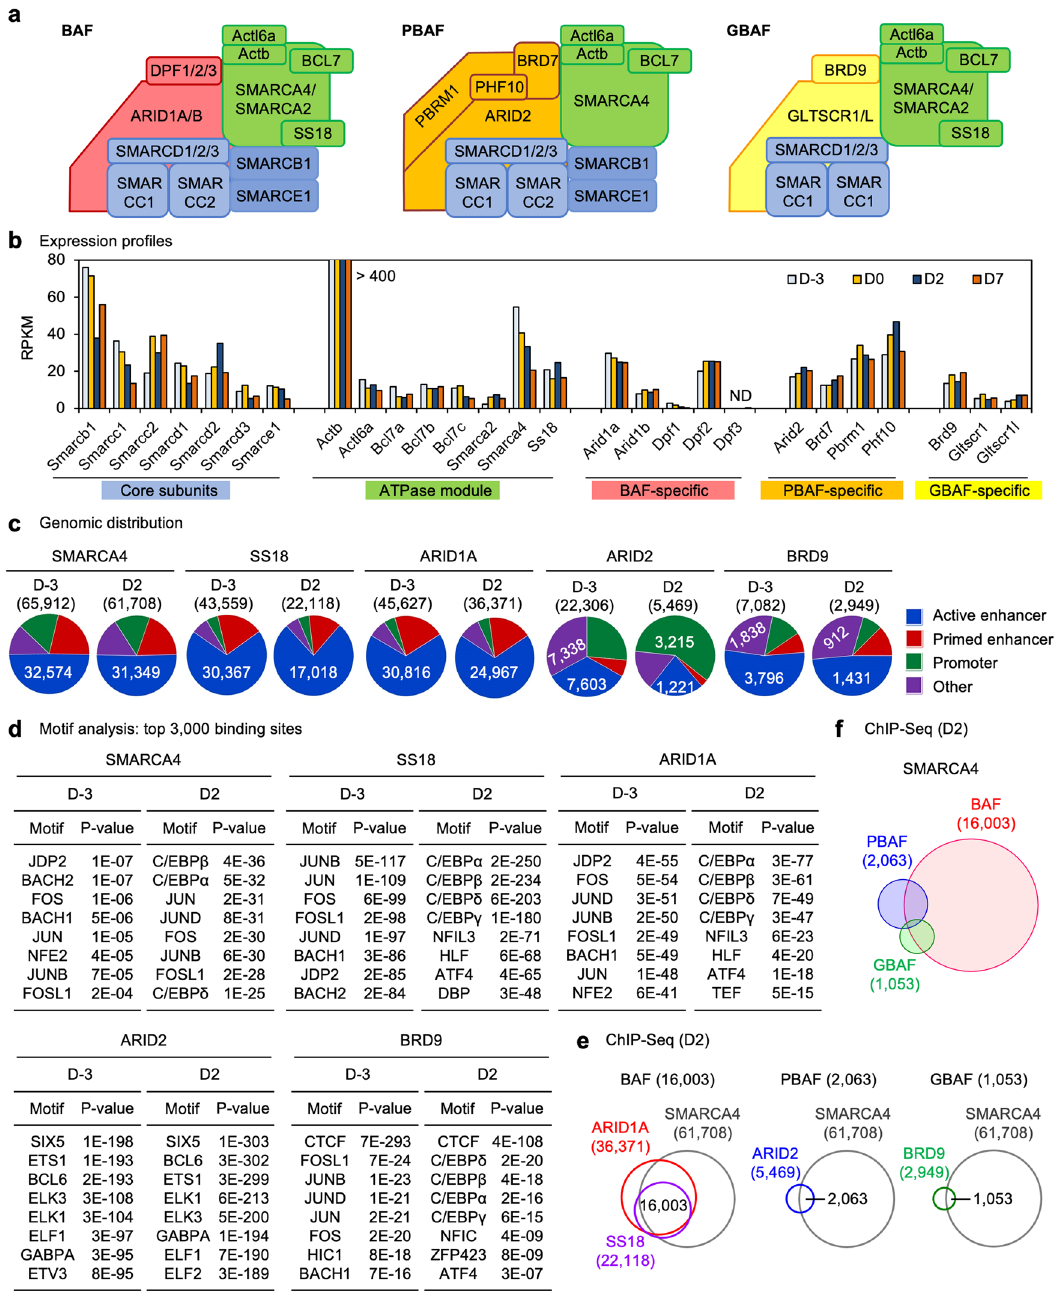
Fig. 1 Expression and genomic binding of SWI/SNF subunits in adipogenesis. a Schematic of subunits in SWI/SNF complexes BAF, PBAF and GBAF (ncBAF). b Expression pro fi les of SWI/SNF subunits in adipogenesis of immortalized brown preadipocytes ( n = 1). Published RNA-Seq data sets were used (GSE74189) 18 . D-3, day -3. D2, day 2. Expression pro fi les of SWI/SNF subunits in adipogenesis of 3T3-L1 white preadipocytes and a different brown preadipocyte cell line are presented in Supplementary Fig. 1a. c Genomic distributions of SMARCA4 (BRG1), SS18, BAF-speci fi c ARID1A, PBAF-speci fi c ARID2 and GBAF-speci fi c BRD9 before (D-3) and during (D2) adipogenesis of brown preadipocytes were determined by ChIP-Seq. Promoters were de fi ned as transcription start sites ±1 kb. Active enhancers were de fi ned as H3K4me1 + H3K27ac + promoter-distal regions. Primed enhancers were de fi ned as H3K4me1 + H3K27ac − promoter-distal regions. Numbers of binding sites are indicated. d Motif analysis of SWI/SNF subunits binding regions at D-3 and D2 of adipogenesis using SeqPos motif tool. Top 3,000 signi fi cant binding regions were used. e Venn diagrams depicting genomic binding of SMARCA4, SS18, ARID1A, ARID2 and BRD9 at D2 of adipogenesis. BAF, PBAF, and GBAF binding sites were de fi ned as SMARCA4 + SS18 + ARID1A + , SMARCA4 + ARID2 + , and SMARCA4 + BRD9 + regions, respectively. f Venn diagram depicting genomic binding of BAF, PBAF and GBAF at D2 of